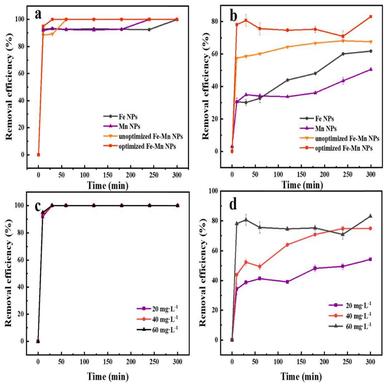
Comparison of Sb(III) (a) and Sb(V) (b) removal using Fe NPs, Mn NPs, and unoptimized and optimized Fe–Mn NPs (pH 5.0, 30 ◦C); The removal efficiency of Sb(III) (c) and Sb(V) (d) under different green tea extract concentration (pH 5.0, 30 ◦C).